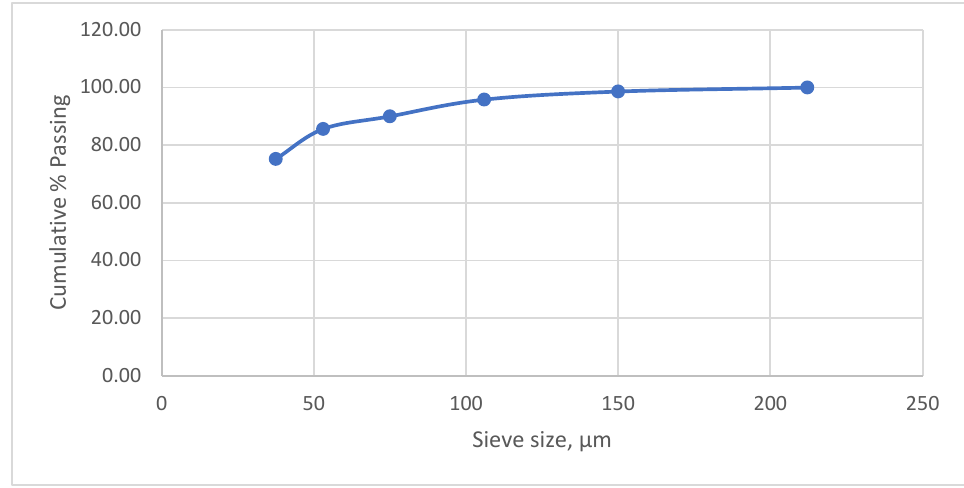
Figure 2. Cumulative percent passing graph.